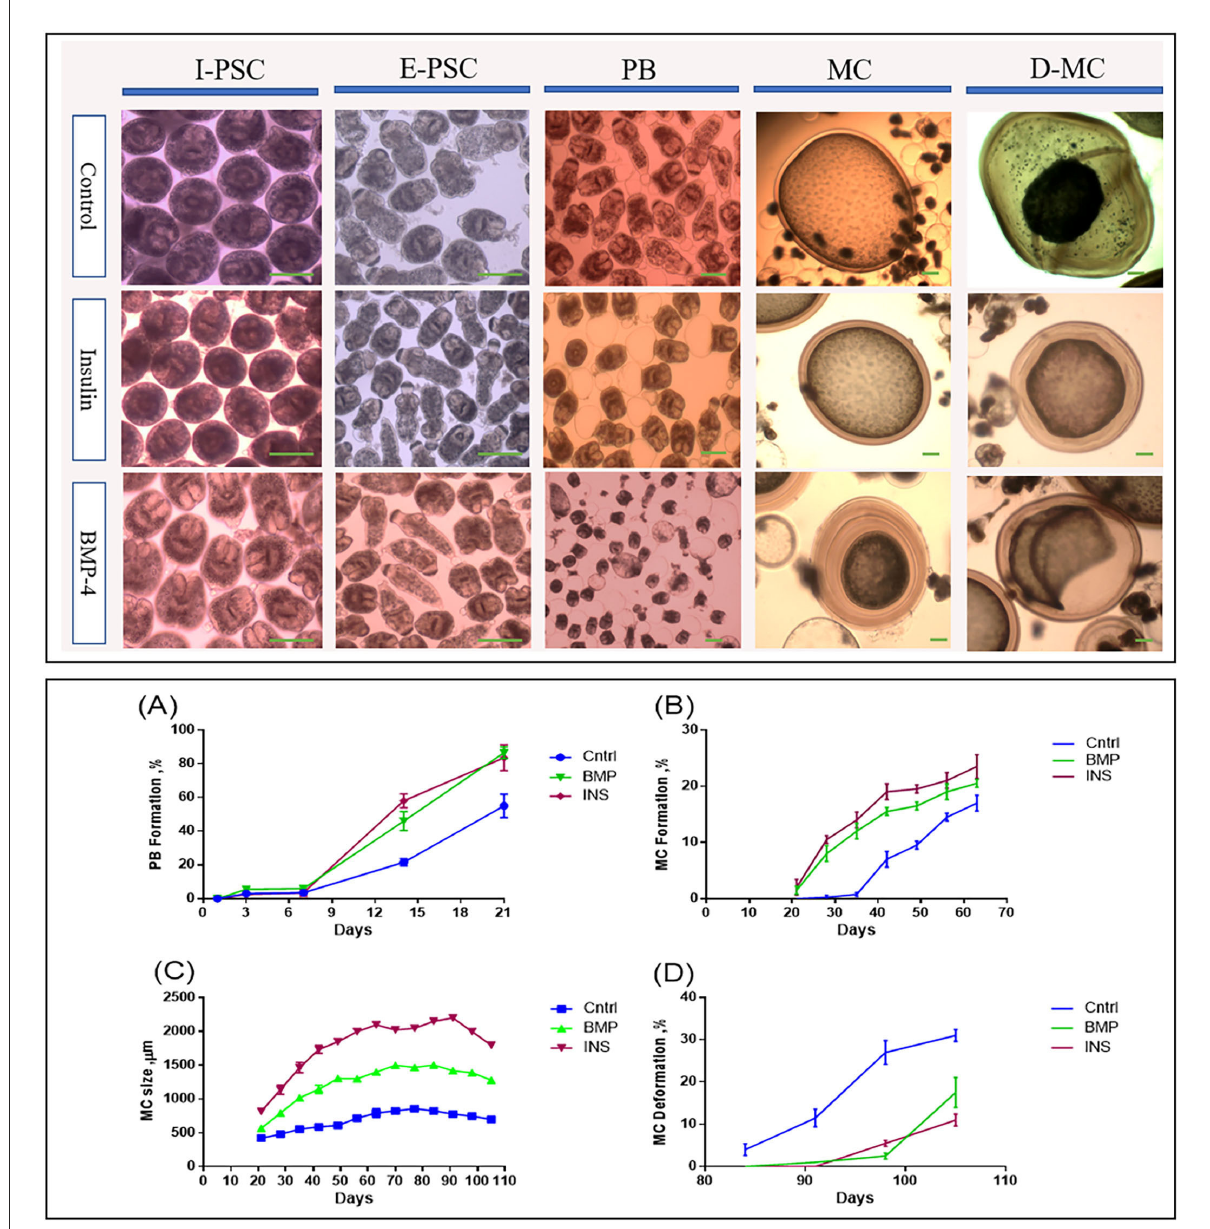
FIGURE2 Morphological and developmental changes in different stages of Echinococcus granulosus from 2000 protoscoleces cultured in DMEM medium. Upper panel: Morphological changes in different in vitro developmental stages of Echinococcus granulosus treated with insulin and BMP-4 compared to the control. I-PSC, Invaginated protoscoleces; E-PSC, Evaginated protoscoleces; PB, Posterior Bladder formation; MC, Microcysts; D-MC, Deformed Microcysts. Lower panel: Developmental changes induced by insulin and BMP-4 treatment in different in vitro stages of Echinococcus granulosus . (A) Posterior Bladder (PB) formation rate. (B) Microcyst formation rate. (C) Average size changes of the microcysts. (D) Microcyst deformation rate. Scale bar: 200 µ m.